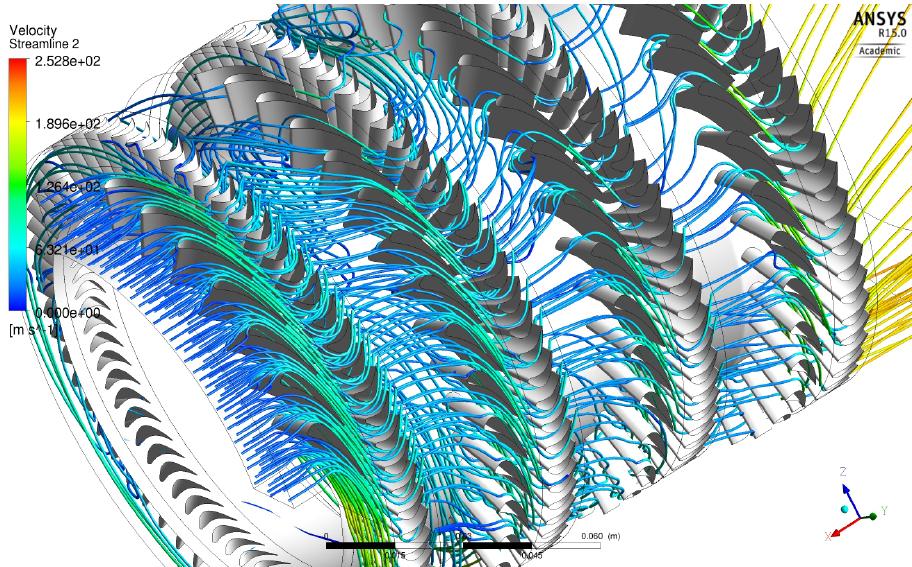
Figure 5: Streamlines coloured by velocity